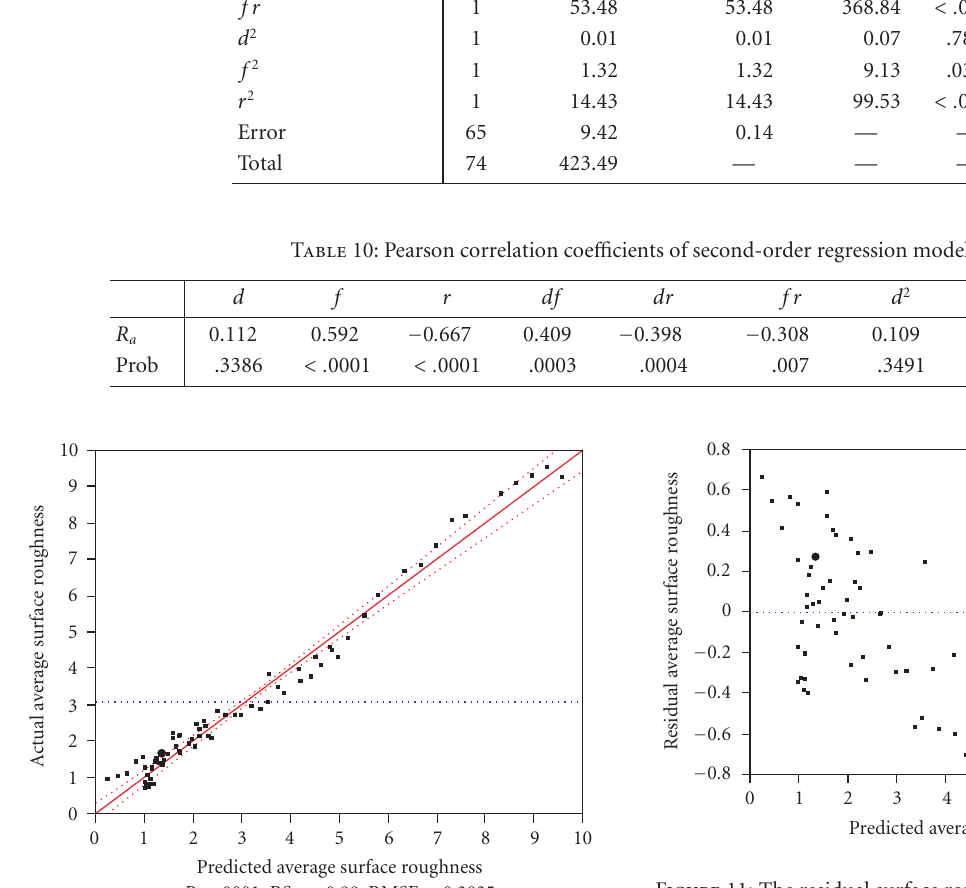
Figure 11: The residual surface roughness versus predicted surface roughness of second-order model.